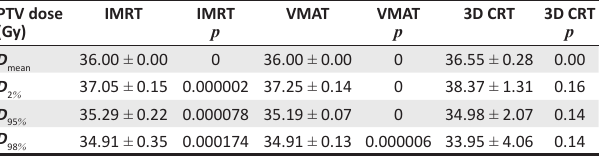
TABLE 3: Planned target volumes mean dose and standard deviation. PTV dose (Gy)